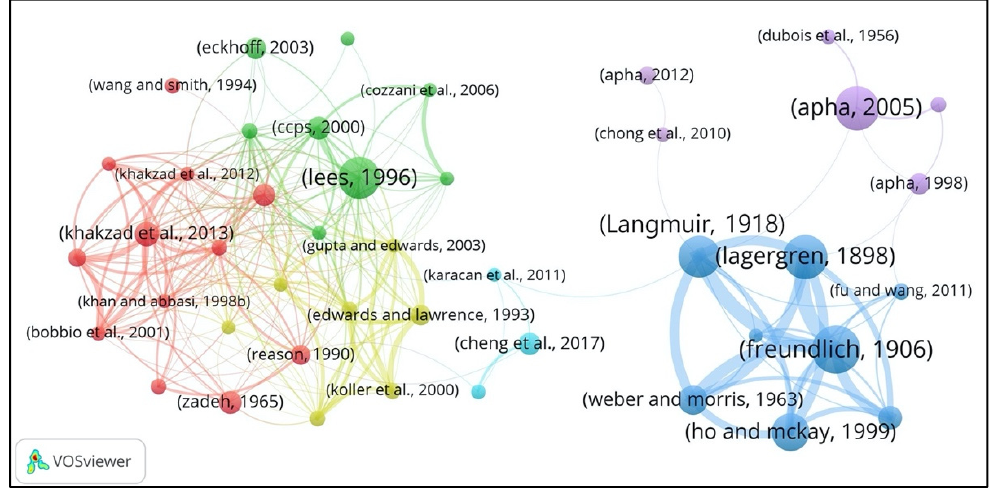
Figure 8. Keyword co-occurrence cluster of PSEP papers. Figure 7. Co-citation network of highly cited reference groups based on co-citation strength.